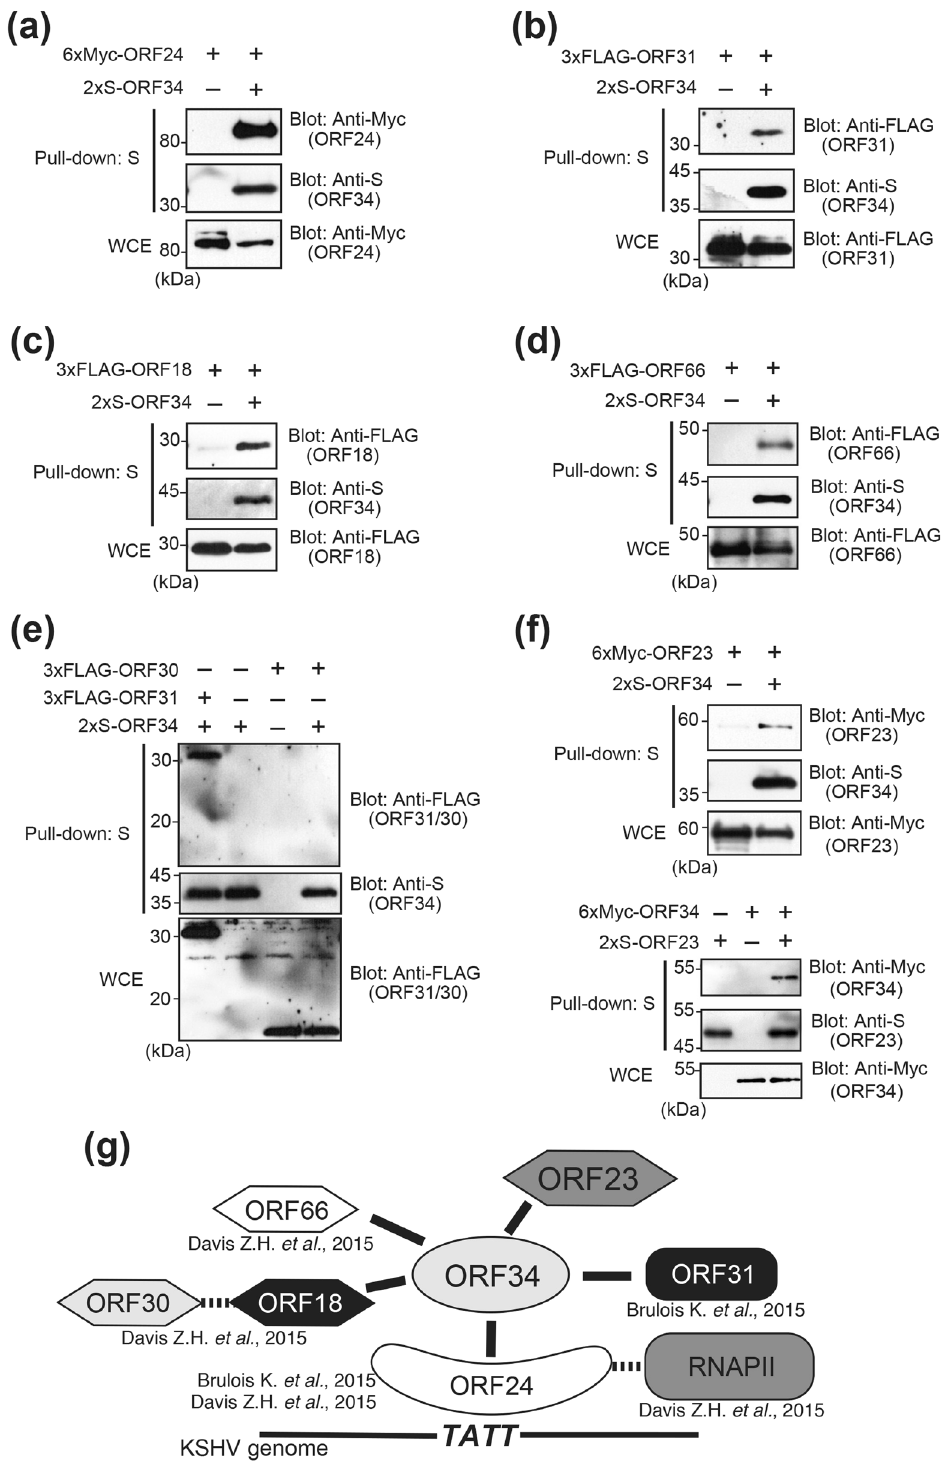
Figure 4. ORF34 physically interacts with ORF24, ORF31, ORF18, ORF23, and ORF66. Cells (293T) were co- transfected with 2xS-tagged ORF34 and 6xMyc-ORF24 ( a ), 3xFLAG-ORF31 ( b ), 3xFLAG-ORF18 ( c ), 3xFLAG- ORF66 ( d ), 3xFLAG-ORF30 ( e ), or 6xMyc-ORF23 ( f ), upper panel) expression plasmids. Cell lysates were subjected to pull-down assays using S-protein-immobilized beads, which captures S-tagged ORF34. The precipitates were immunoblotted with anti-Myc or FLAG antibody to detect their interactions. ( e ) The pull-down sample was precipitated from cell extracts co-transfected with 2xS-ORF34 and 3xFLAG-ORF31, was applied in the left lane as the positive control. ( f ), lower panel) The pull-down sample was precipitated from cell extracts co-transfected with 2xS-ORF23 and 6xMyc-ORF34. ( a – f ) Original images of blotting data are shown in Supplementary Figs S3–S8. ( g ) Schematic depiction of the interactions between KSHV ORF34 and KSHV-PIC component